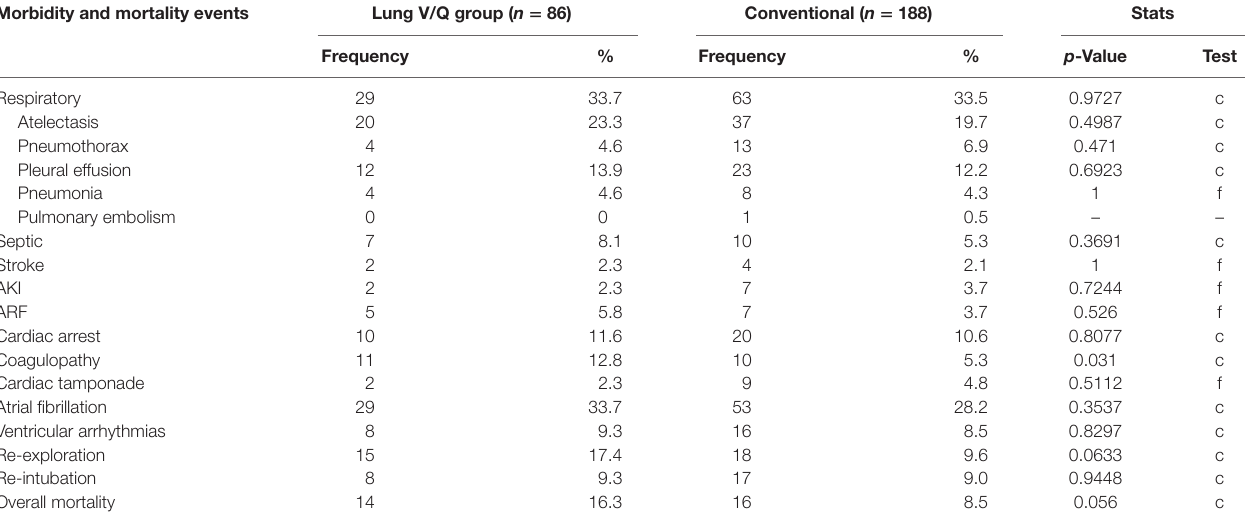
TaBle 4 | Postoperative morbidity and mortality.